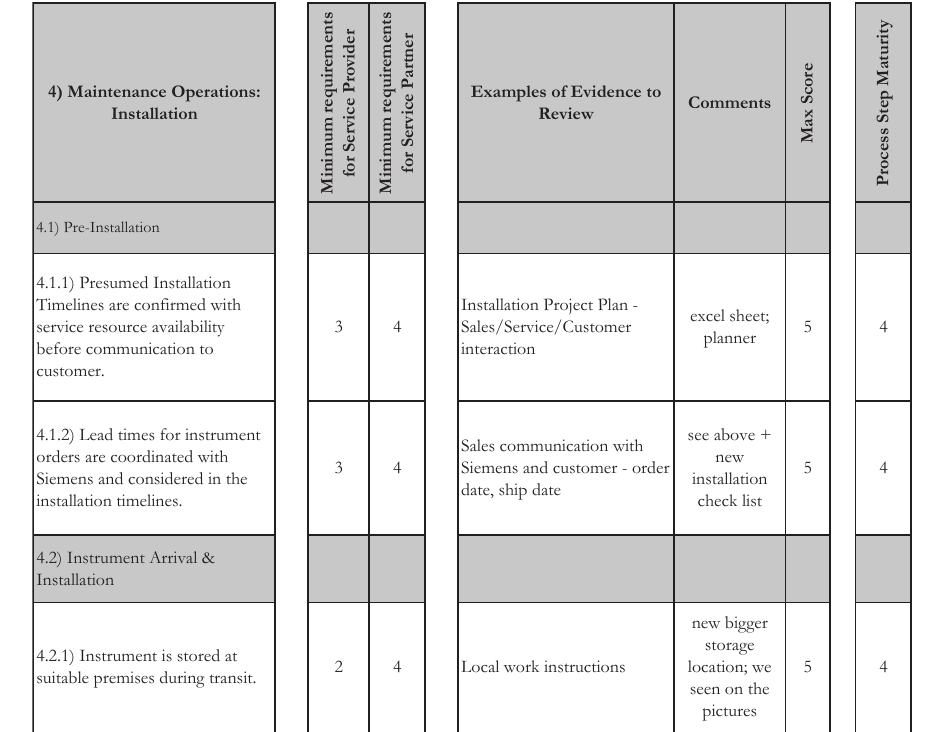
Tab. 3 – An example of assessment table part. Source: